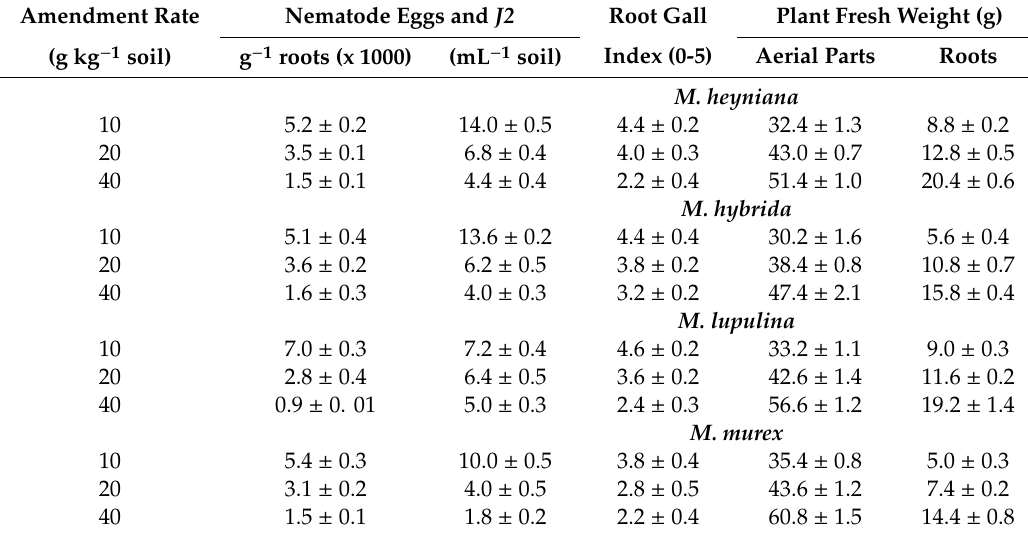
Table 8. E ff ect of soil amendments with dry plant biomass of the five tested Medicago species on the infestation of the root-knot nematode M. incognita and on the growth of tomato cv. Regina (means ±